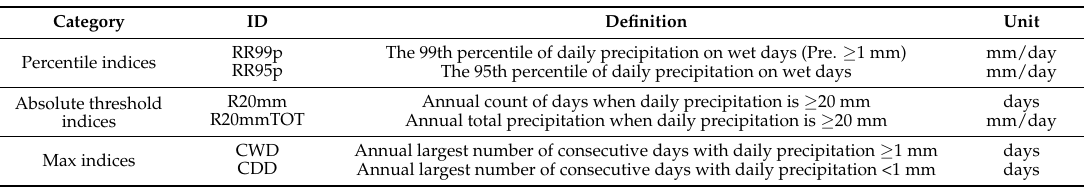
Table 4. Extreme precipitation indices used in the